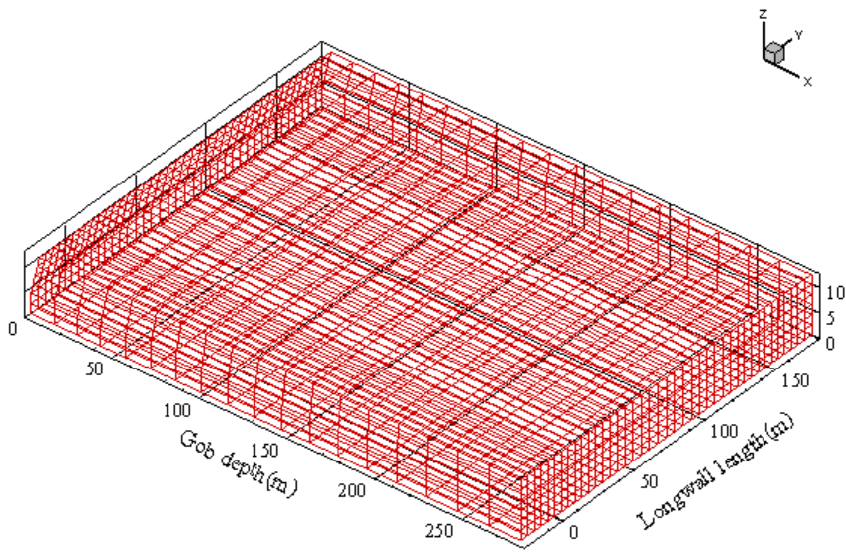
Figure 9. Mesh generation of the model of the goaf area.